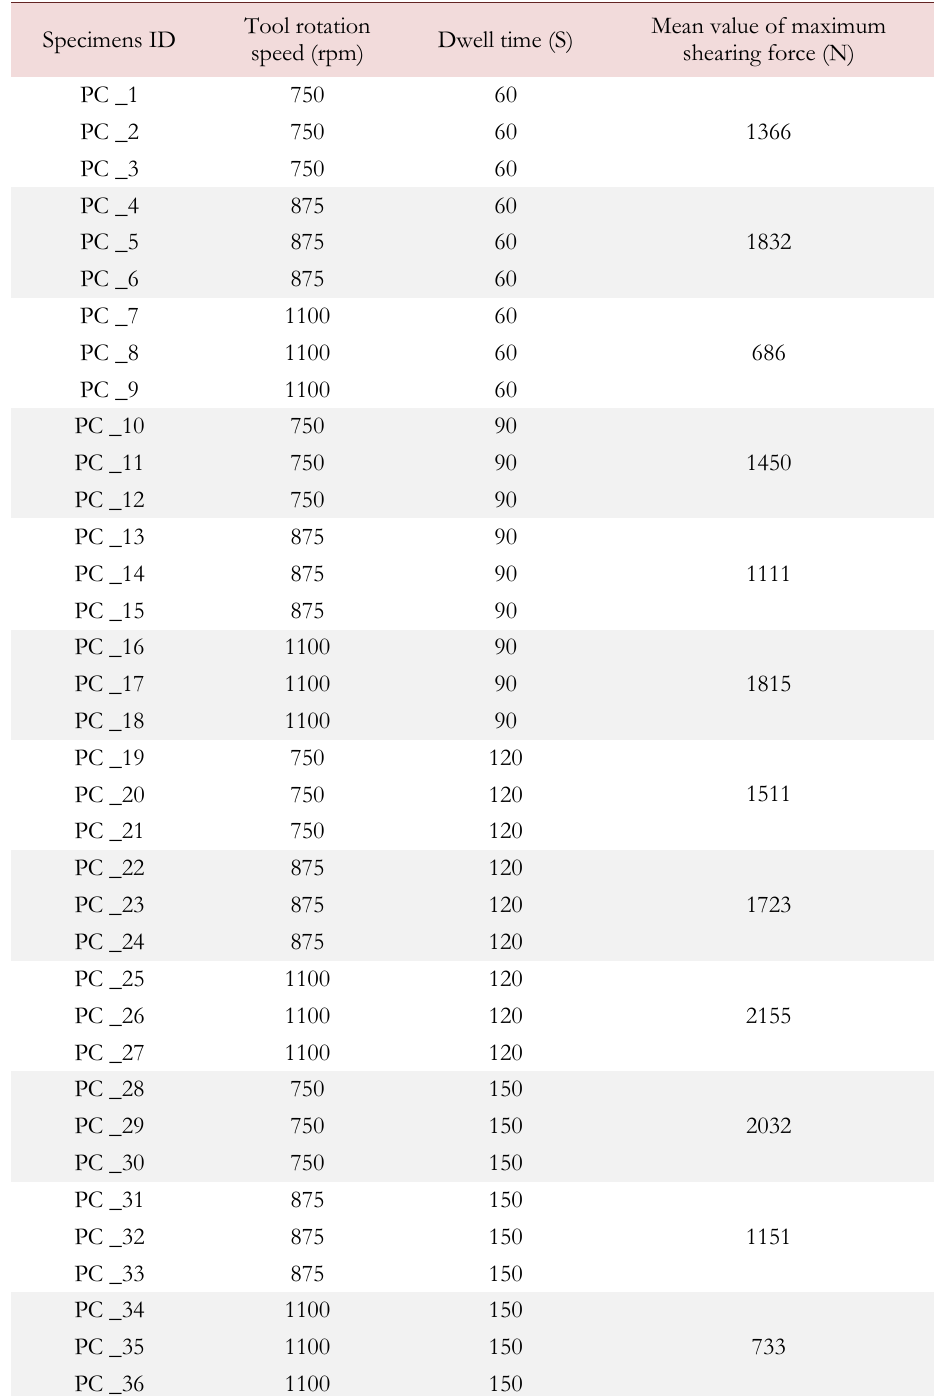
Table 2: Welding parameters